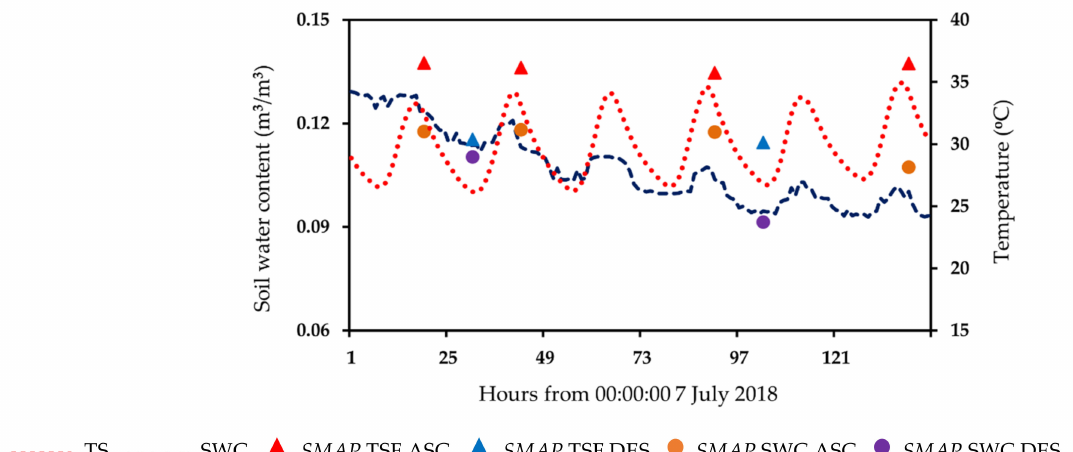
Figure 4. Hourly in situ SWC, soil temperature, SMAP SWC and SMAP surface temperature at ascending and descending nodes at LWREW; the red dotted lines and the blue dashed lines represent the soil temperature and the SWC at 5-centimeter depth, respectively. The orange and purple dots represent the SMAP SWC ASC and DES, the red and blue triangles are SMAP TSF ASC and